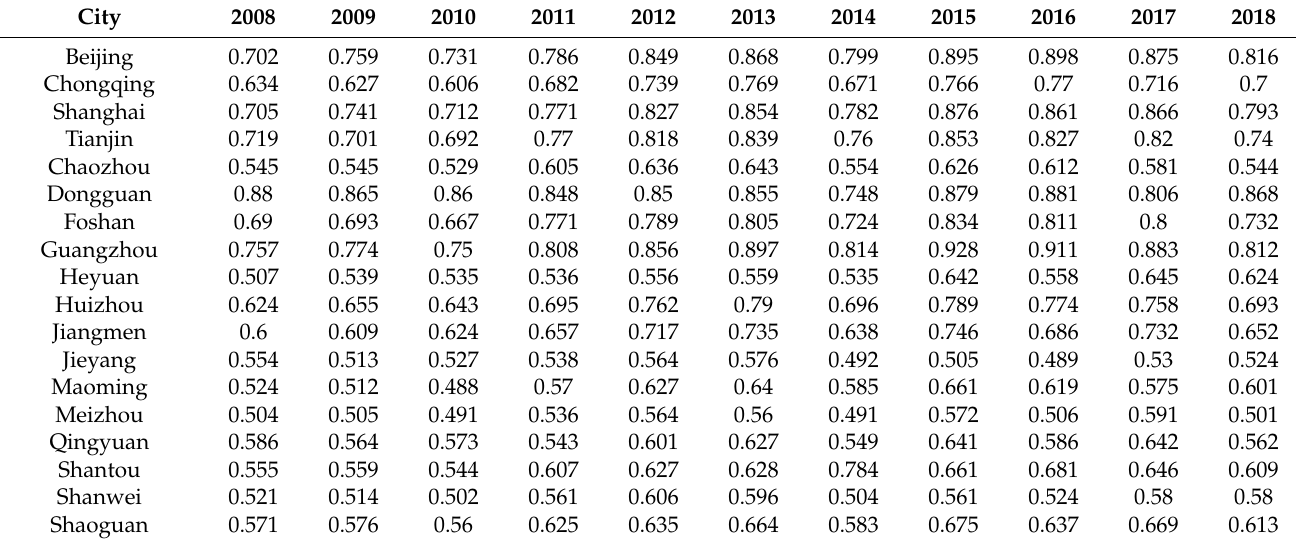
Table 1. The CCD values for economic development and environmental quality subsystems from 2008 to 2018.